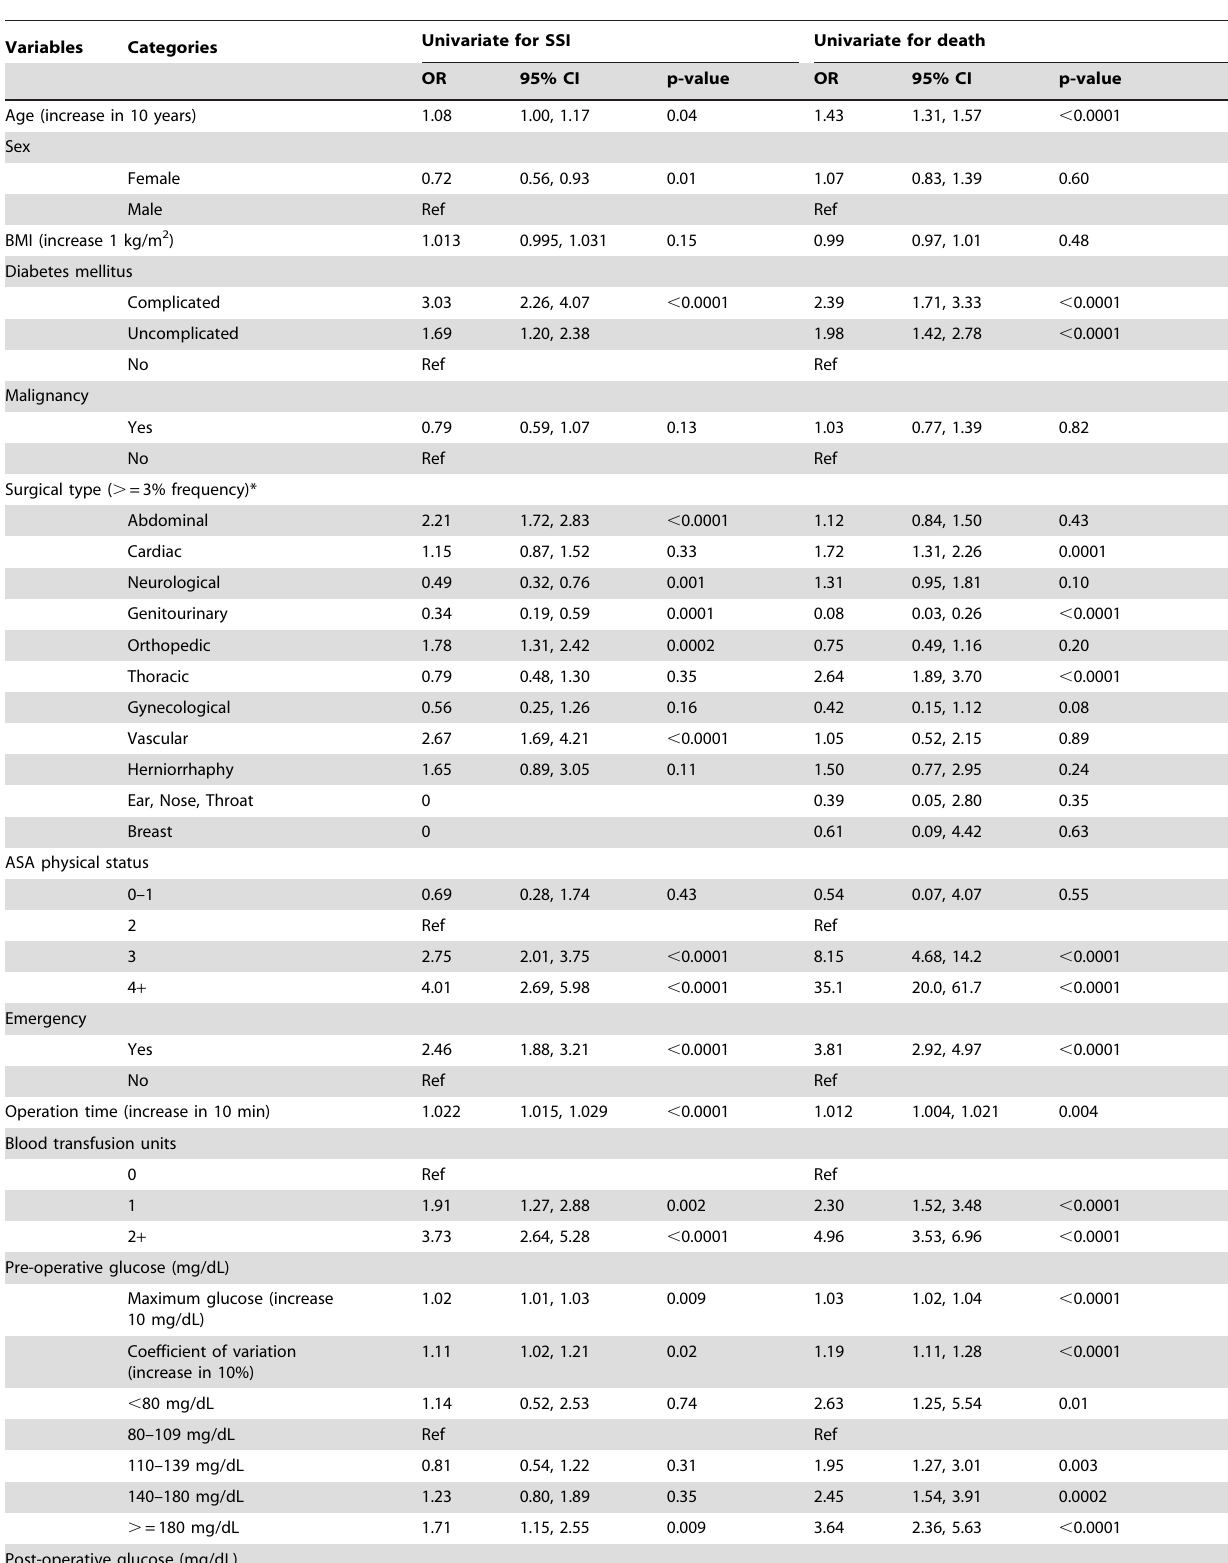
Table 2. Relationship between demographic, clinical and operative factors and surgical site infections and death.